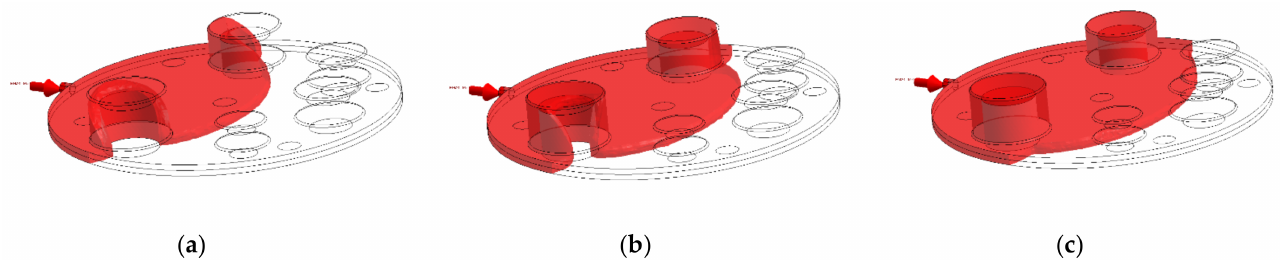
Figure 12. ( a ) Flow front when it covers the front face of the pin; ( b ) flow front moving over the pin; ( c ) flow front when the pin is fully surrounded by the melt.